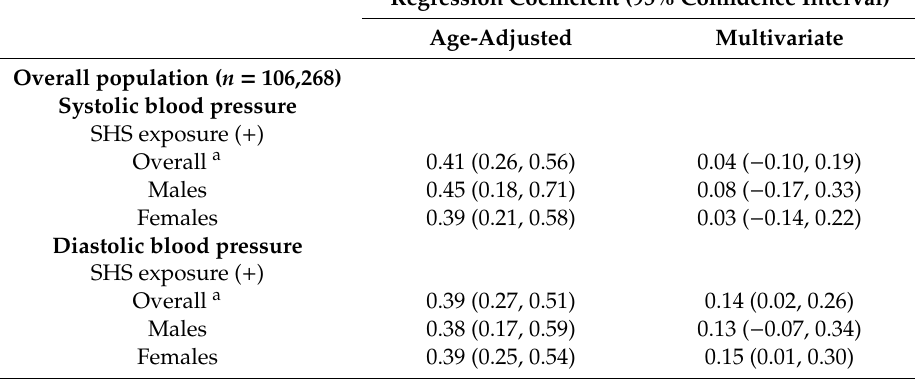
Table 5. Multivariate linear regression analyses for the association of blood pressure with secondhand smoke exposure in never-smokers including and excluding individuals with antihypertensive